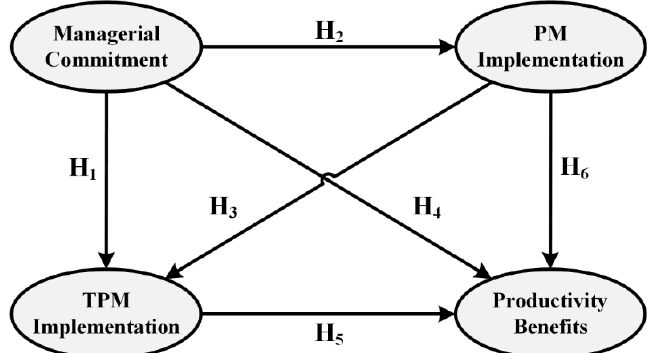
Figure 1. Initial model. TPM, total productive maintenance; PM, preventive maintenance.